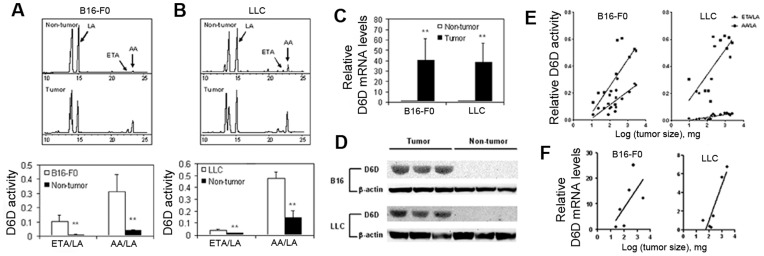
D6D activity is higher in tumor tissue than in adjacent non-tumor tissue.(a) The activity of biomarkers of D6D in B16 melanoma. Upper: Gas chromatography showing the differences in LA, ETA and AA content between B16 melanoma and adjacent non-tumor tissue. Lower: The ratios of ETA/LA and AA/LA indicate D6D enzyme activity. **P<0.01, n = 4. (b) Activity of biomarkers of D6D in LLC tumors. Upper: Gas chromatography showing the differences in LA, ETA and AA content between LLC tumor and adjacent non-tumor tissue. Lower: The ratios of ETA/LA and AA/LA indicate D6D enzyme activity. **P<0.01, n = 4. (c) D6D mRNA levels in tumor and adjacent non-tumor tissue. **P<0.01, n = 3. (d) Western blot showing D6D protein levels in tumor and adjacent non-tumor tissue. (e) Correlation of the activity of biomarkers of D6D (based on ETA/LA and AA/LA ratios) with tumor size. (f) Correlation of D6D mRNA levels with tumor size.